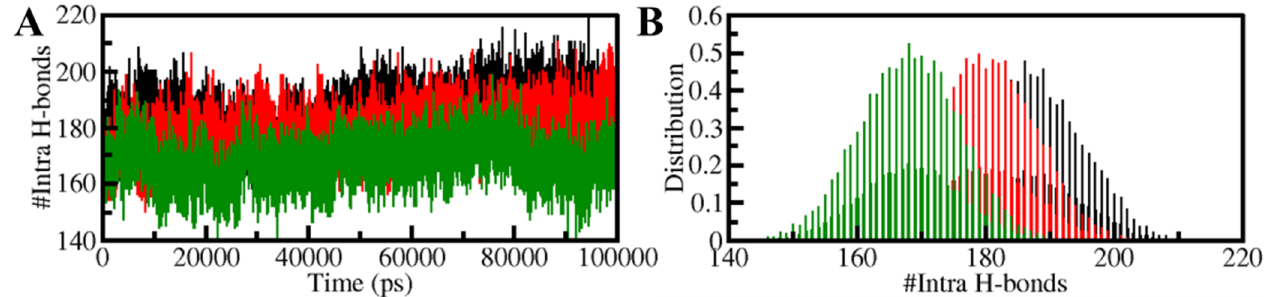
Figure 5. Intramolecular hydrogen bonding. ( A ) Hydrogen bonds formed intra-PDPK1. ( B ) The probability density function (PDF) of the intramolecular H-bonds within PDPK1.